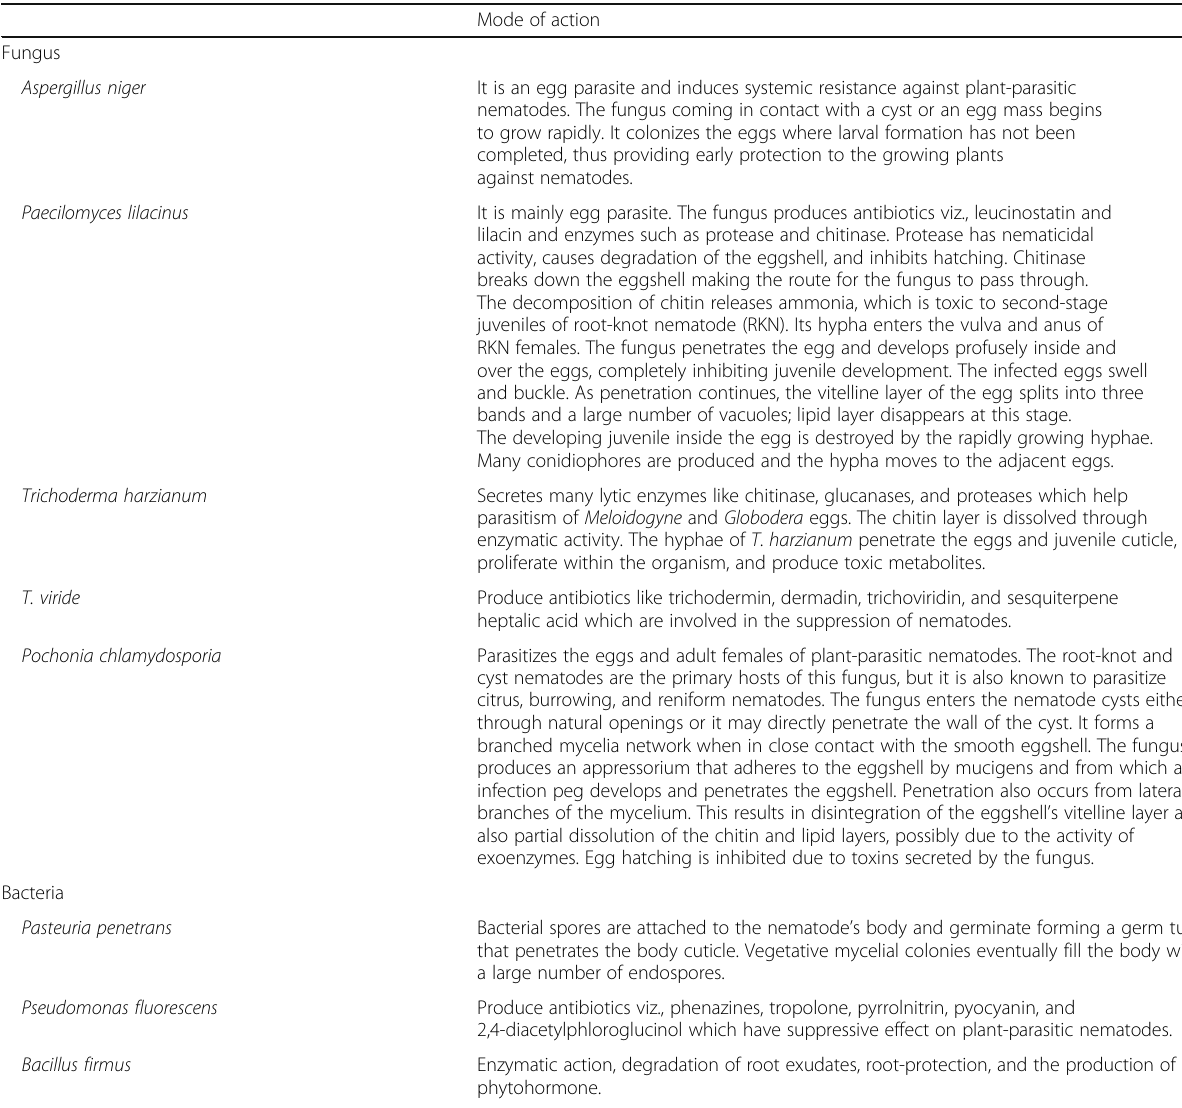
Table 2 Modes of action of fungal and bacterial biocontrol agents against phytonematodes (Askary and Martinelli 2015) Mode of